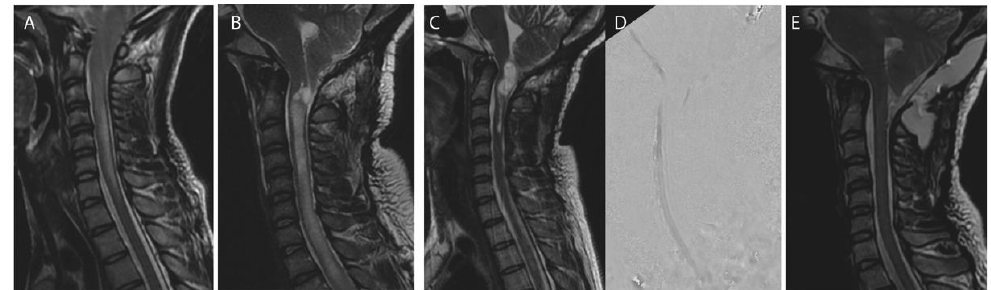
Figure 1. Time to first reintervention following Chiari decompression.